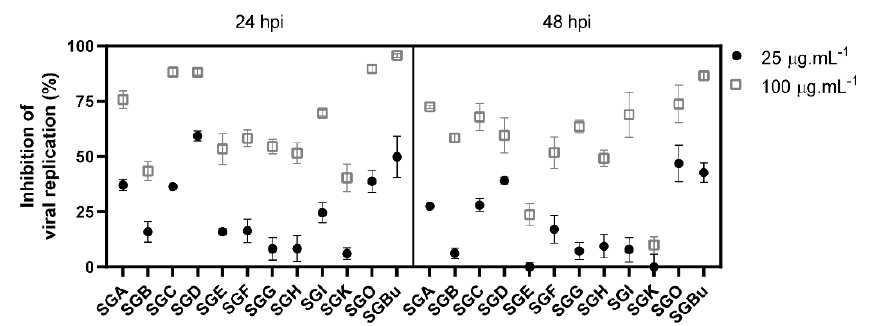
Figure 1. Inhibition of influenza virus replication by CPC pooled fractions with cell viability above